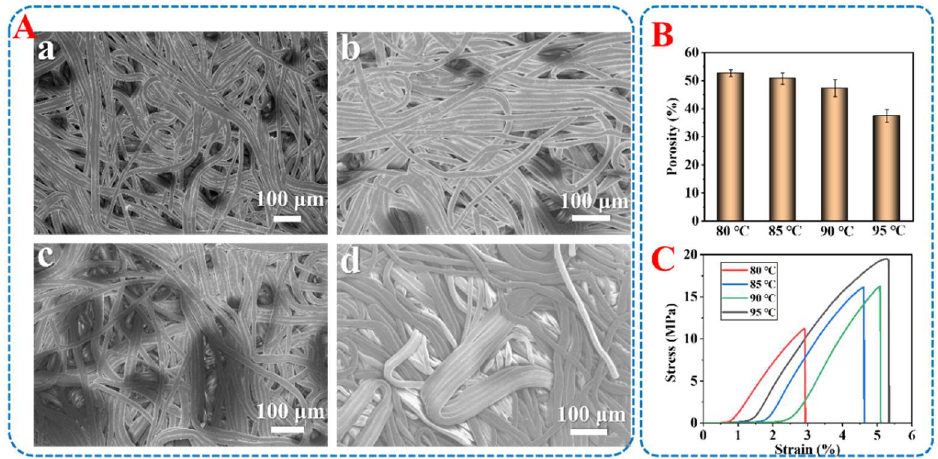
Figure 2. Basic properties of PPS matrix. ( A ) Surface SEM images of PPS fiber membranes (a: 80 °C; b: 88 °C; c: 90 °C; d: 95 °C); ( B ) porosity of PPS fiber membranes; ( C ) stress–strain curve of PPS fiber membranes.